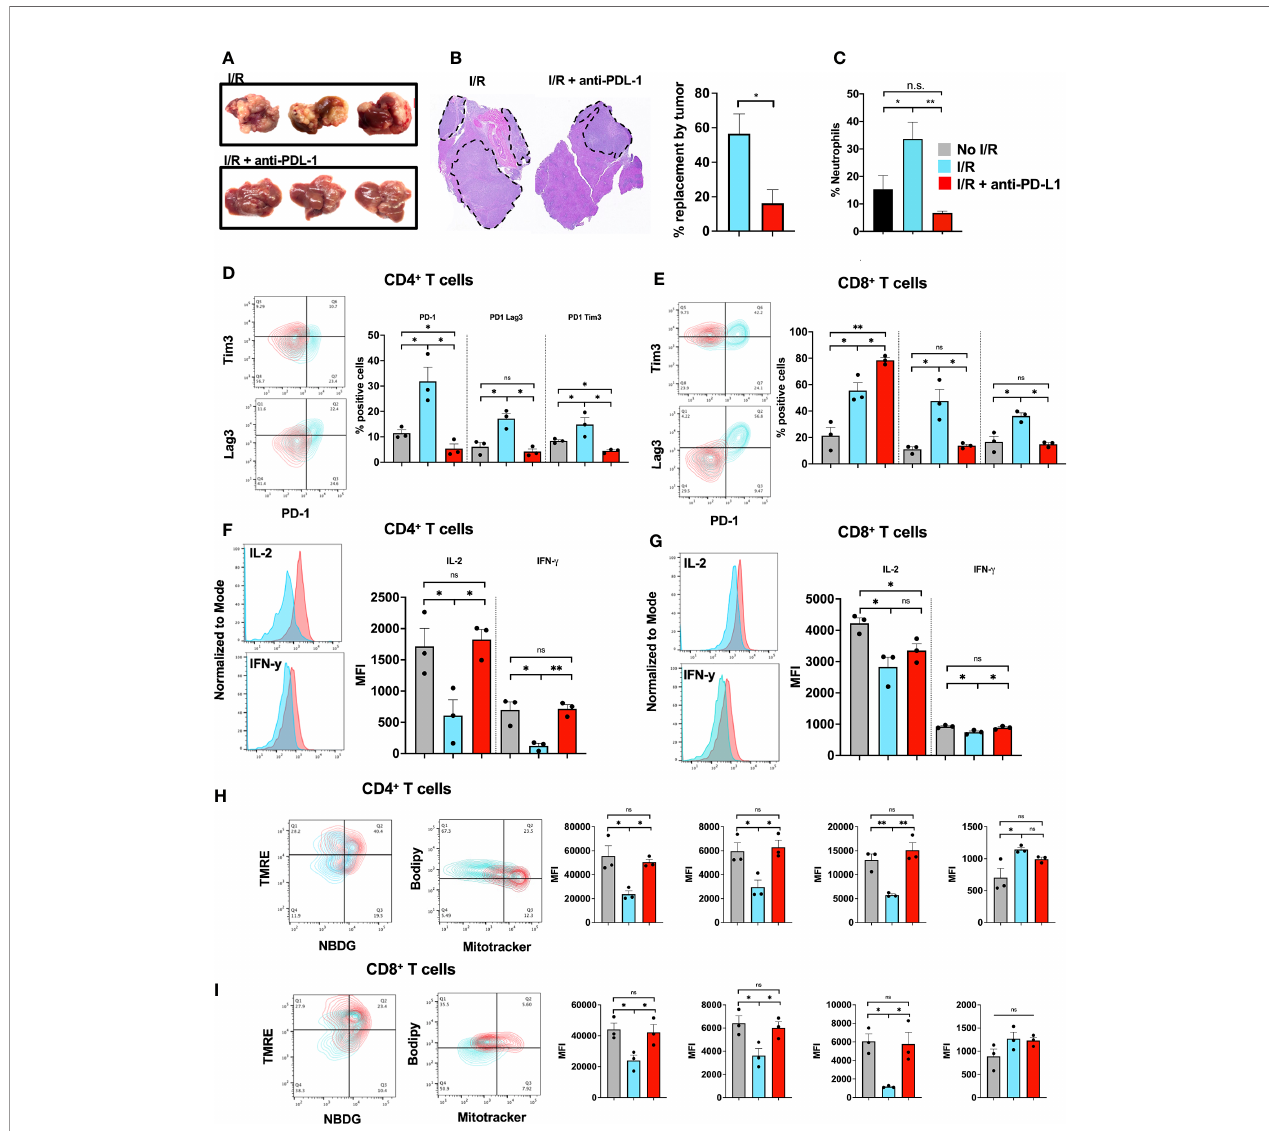
FIGURE 7 | Blocking of PD-L1 at time of I/R is suf fi cient to abrogate tumor growth. (A) WT Mice underwent portal vein tumor infusion followed by I/R on day 6. Mice treated with I/R and anti-PD-L1 antibody had signi fi cantly decreased tumor burden at 3 weeks (B) H&E showed that animals that underwent IR and anti-PD-L1 treatment had smaller microscopic tumors. (C) Animals treated with anti-PD-L1 antibody had signi fi cantly decreased levels of neutrophils in the TME. (D, E) CD4 + and CD8 + T cells in fi ltrating tumors 3 weeks after liver I/R in WT mice expressed increase exhaustion markers (F, G) reduced T cell cytokine production (H, I) and altered metabolic function. Anti-PD-L1 antibody administration at time of I/R prevented these T cell changes. Bar graphs represent mean +/- SEM of two independent experiments, performed with three mice each. *p < 0.05, **p <